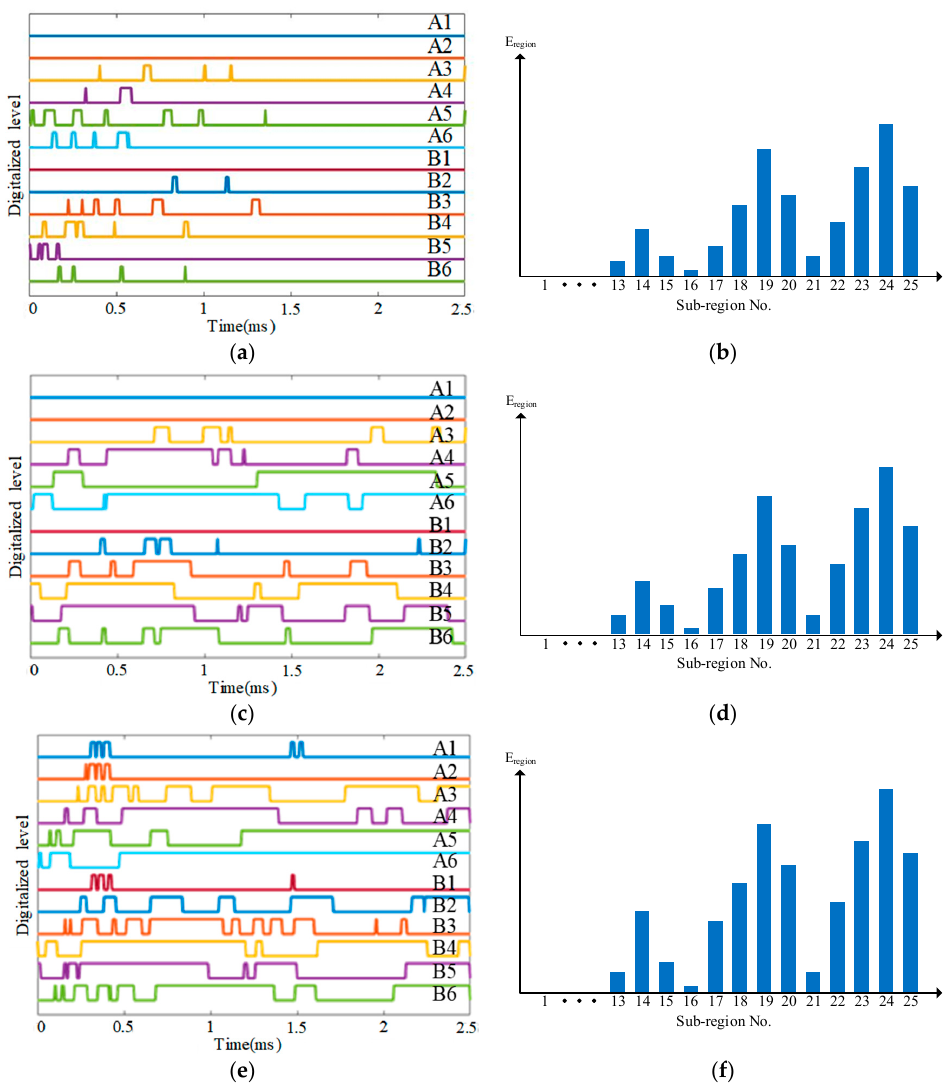
Figure 26. Typical impact region monitoring results on the UAV composite skin based on CPSN under different energy levels: ( a ) CDSs and ( b ) E region of all sub-regions under energy level 1; ( c ) CDSs and ( d ) E region of all sub-regions under energy level 2; ( e ) CDSs and ( f ) E region of all sub-regions under energy level 3.